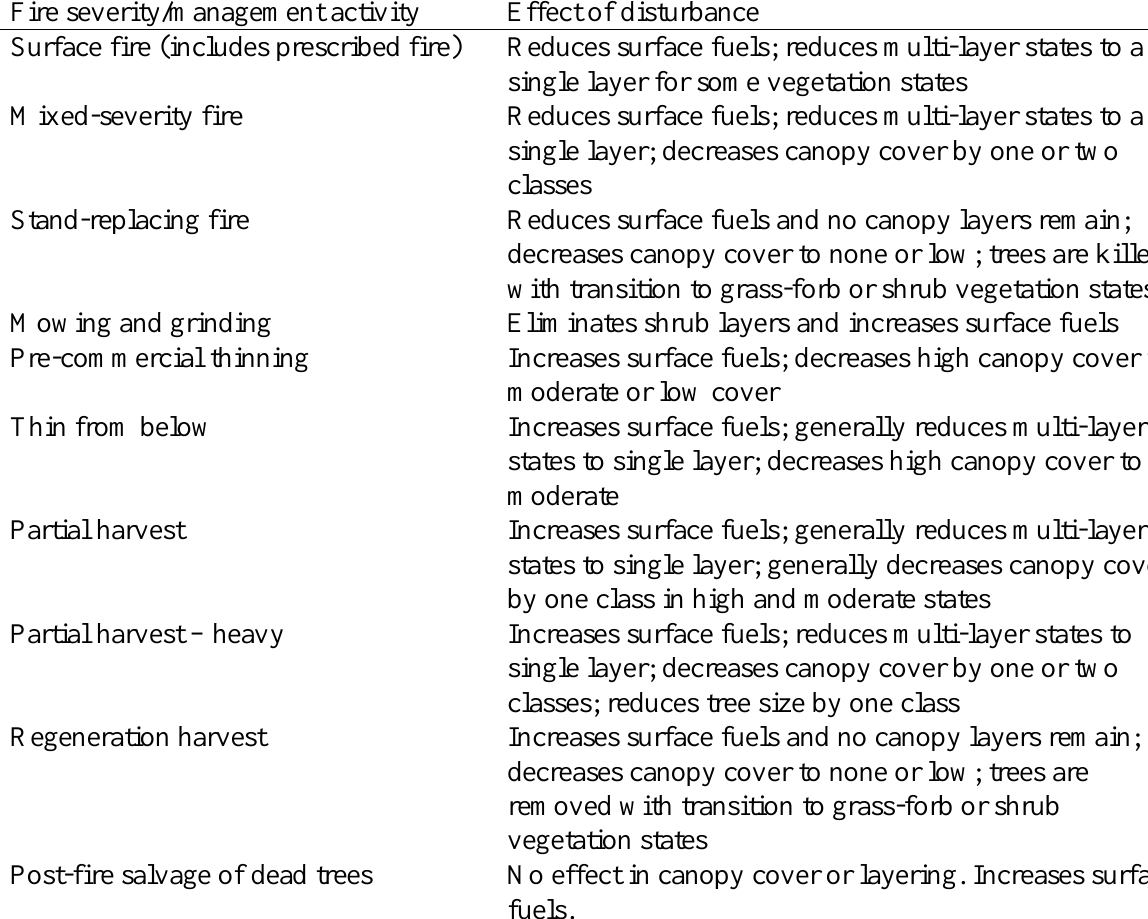
Table A2.1. Effect of fire severity and management action on tree size, canopy cover, canopy layering and surface